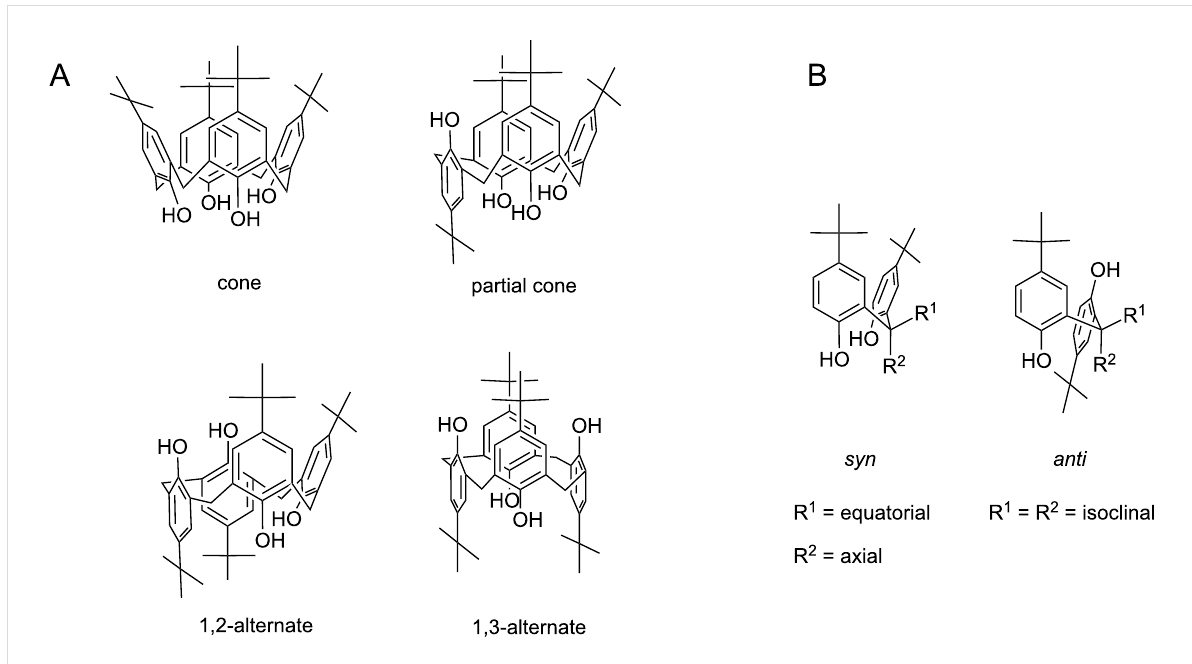
Figure 1: A: Four fundamental conformations of a calix[4]arene. B: Arrangement of the methylene group substituents with respect to the orientation of the neighbouring arene